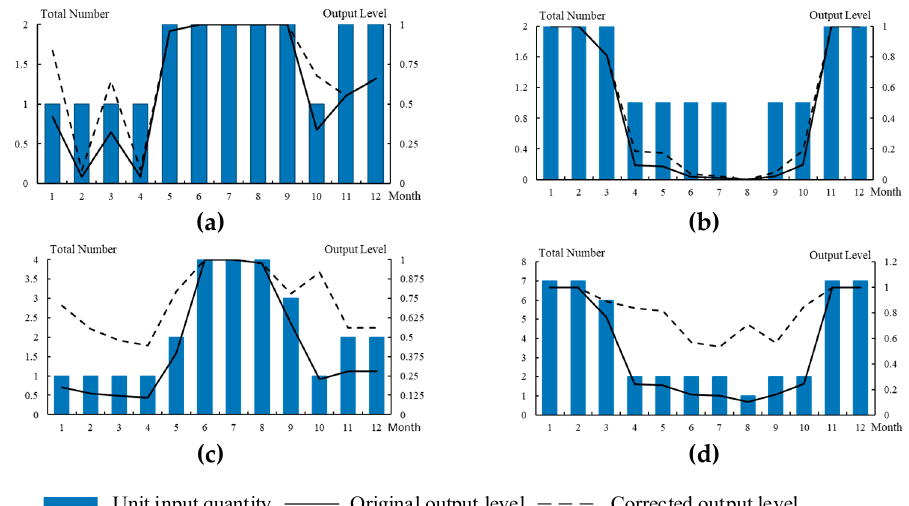
Figure 10. Device output level and unit adjustment: ( a ) electric refrigerator; ( b ) electric-heat pump; ( c ) absorption chiller; ( d ) waste-heat boiler.